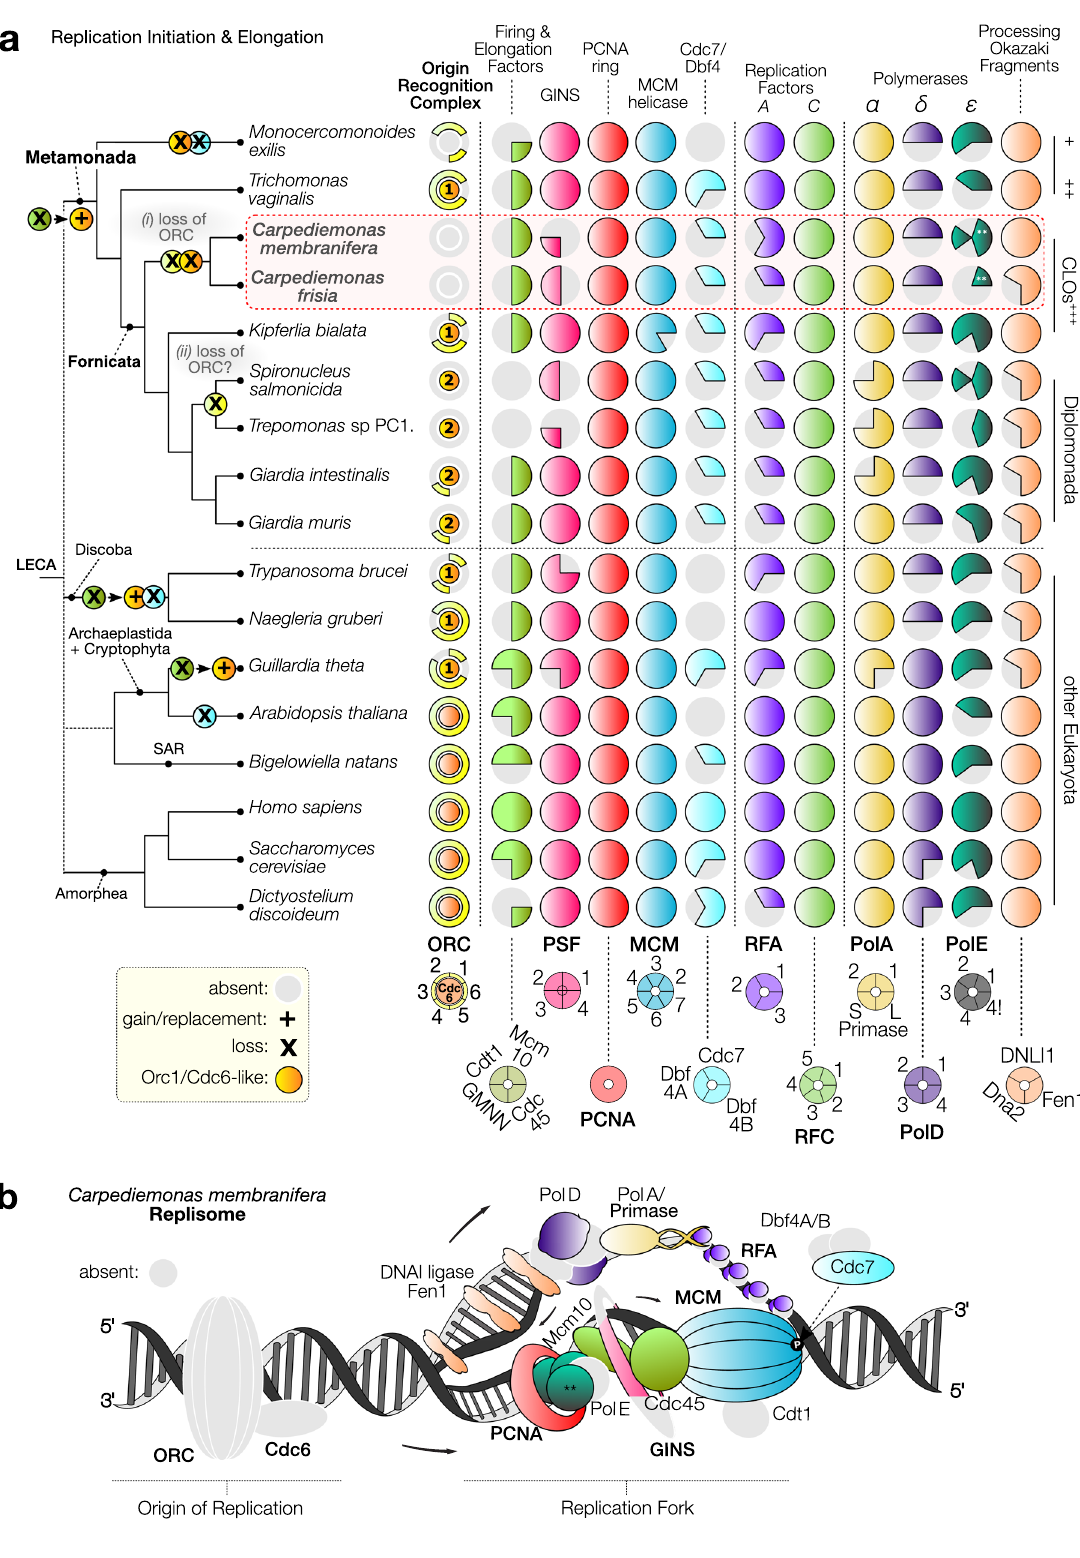
The correct version of Fig. 1 is